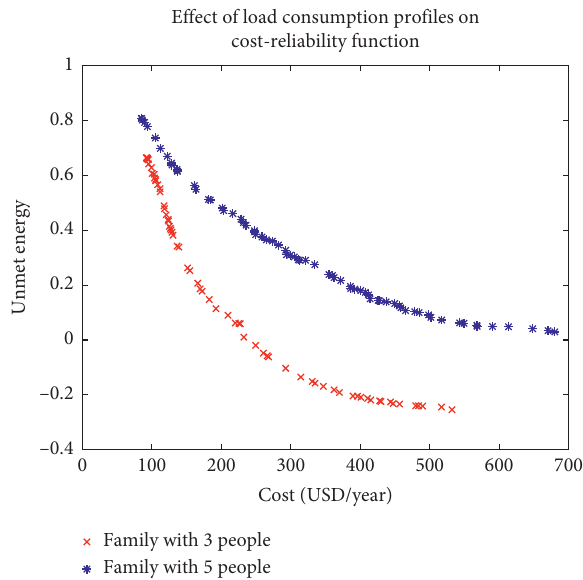
Figure 5: The cost-reliability comparison of two identical systems connected to different households (PV panels tilt angle: 65 ° toward south; wind turbine hub height:12 m; battery type: Li-ion batteries; using measured weather data from Holt).